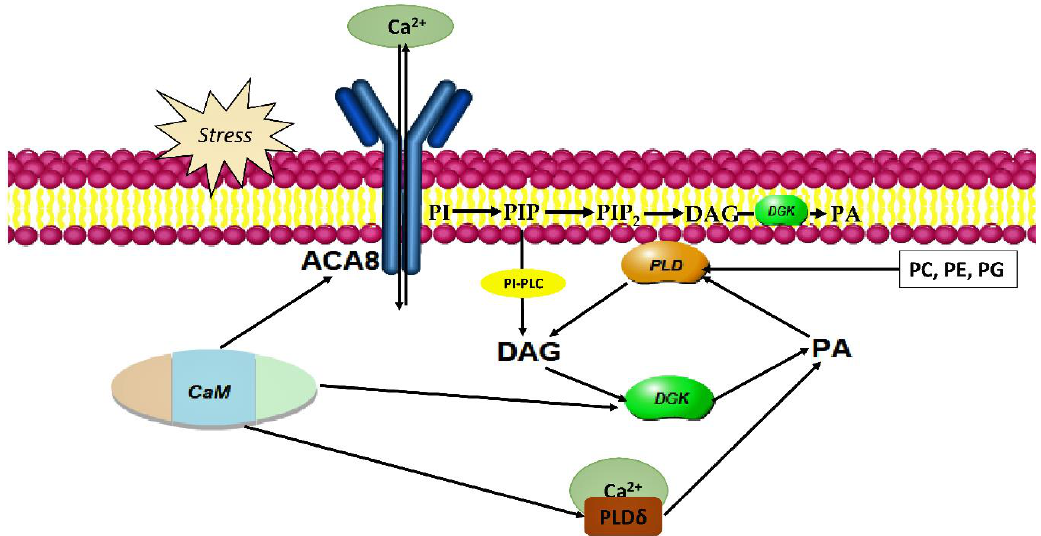
Figure 3. The role of DGKs in plant development; maintaining of the balance between the phosphatidic acids (PA) generation and the diacylglycerol (DAG) production by the coupled actions of the phospholipase D (PLD) and diacylglycerol kinase (DGK), which are both activated by the CaM-binding enzymes. phosphatidylcholine (PC), phosphatidylethanolamine (PE), and phosphatidylglycerol (PG) also activate PLD.